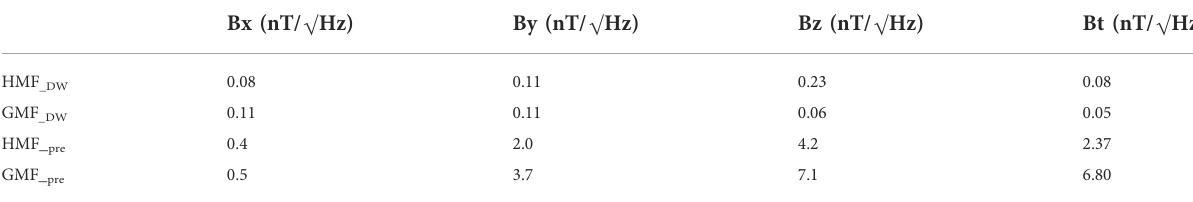
TABLE 1 The square root of power spectral density (PSD) at 50 Hz within the GMF and HMF cages in this study and our previous study. DW, double- wrapped coils in this study; pre, helmholtz coils used in our previous study